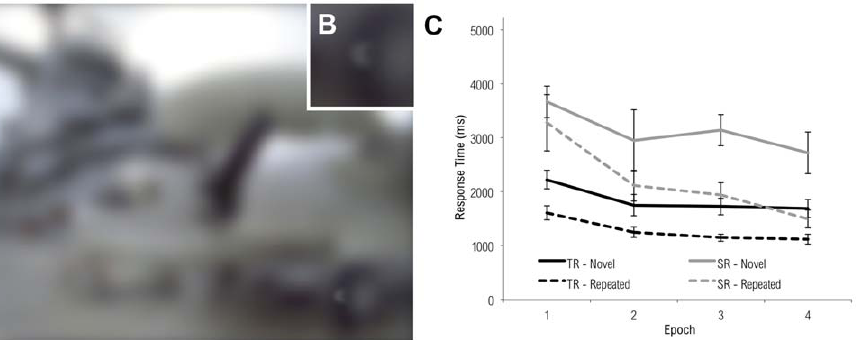
Figure 6. Example stimulus used in Experiment 3. (A) Participants search for a C or backwards C target (aircraft tire, lower right). Search times in novel and repeated contexts are compared to observe a contextual learning effect. (B) Inset detail reveals target location. (C) Results of reaction time analysis for Experiment 3. Individuals with dyslexia, but not typical readers, show evidence of contextual learning.